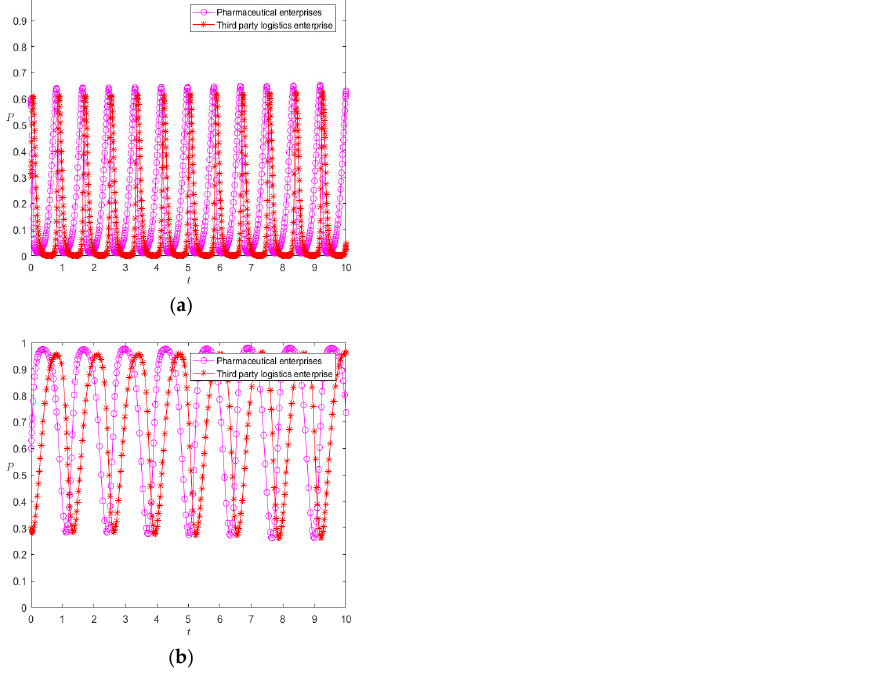
Figure 9. Evolution results of pharmaceutical enterprises ( a ) and 3PL enterprises ( b ) under the static premium and penalty mechanism.